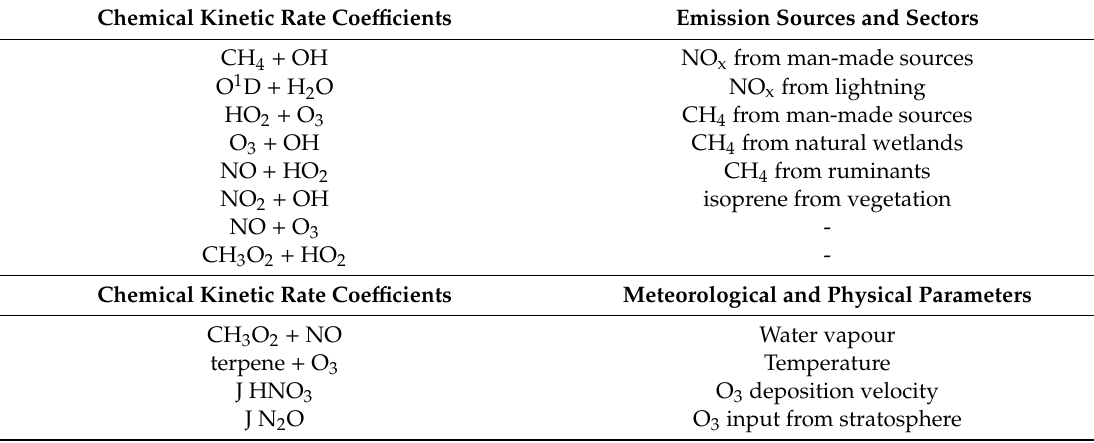
Table 3. Details of the most important input parameters contributing to the uncertainty in the burdens of O 3 and CH 4 , the adjustment times for CH 4 and O 3 and the GWP for CH 4